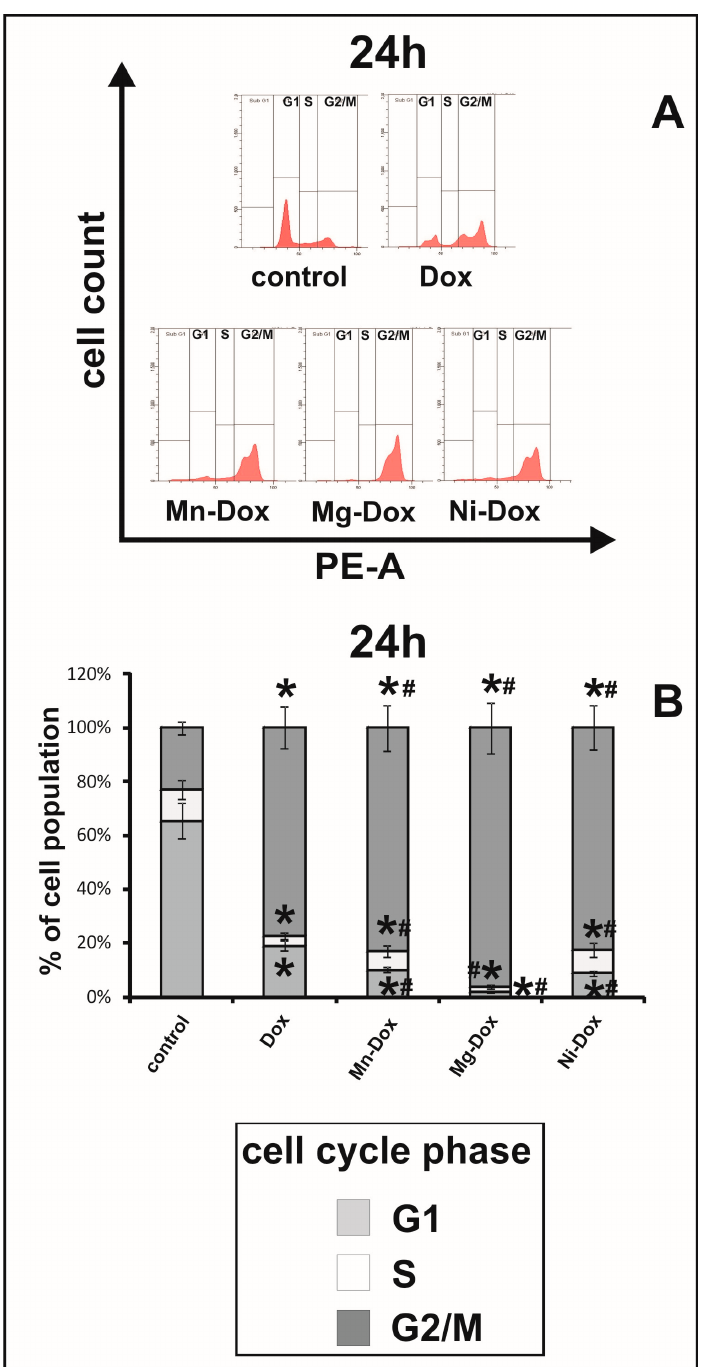
Figure 12 The effect of DOX, Ni-DOX, Mn-DOX and Mg-DOX on cell cycle distribution of MCF-7 cell line. The cell cycle was measured by propidium iodide staining followed by flow cytometry analysis. Results are shown for cells treated with 0.5 µM Ni-DOX, Mn-DOX and Mg-DOX for 24 h versus untreated controls and versus 0.5 µM DOX. Graphical representation of the cell cycle profiles obtained from flow cytometry measurements in MCF-7 cells is depicted in ( A ). Bar graph presenting the percentage of cell cycle distribution in MCF-7 after 24 h ( B ) of treatment with DOX, Ni-DOX, Mn-DOX and Mg-DOX. Significant alterations are expressed relative to control and marked with asterisks (*); significant alterations are expressed relative to DOX-control and marked with crosses (#). Statistical significance was considered if *# p < 0.05.